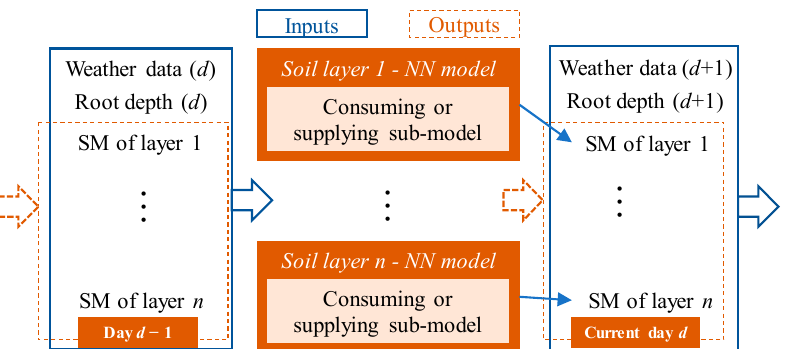
Figure 3. Diagram of each neural network (NN) model. SM: soil moisture; n indicates the number of soil layers; d indicates the current day, while ( d − 1) and ( d + 1) indicate yesterday and the next day, respectively; the box with solid border line marked the input variables of the NN model, whereas the box with dash border line marked the output.